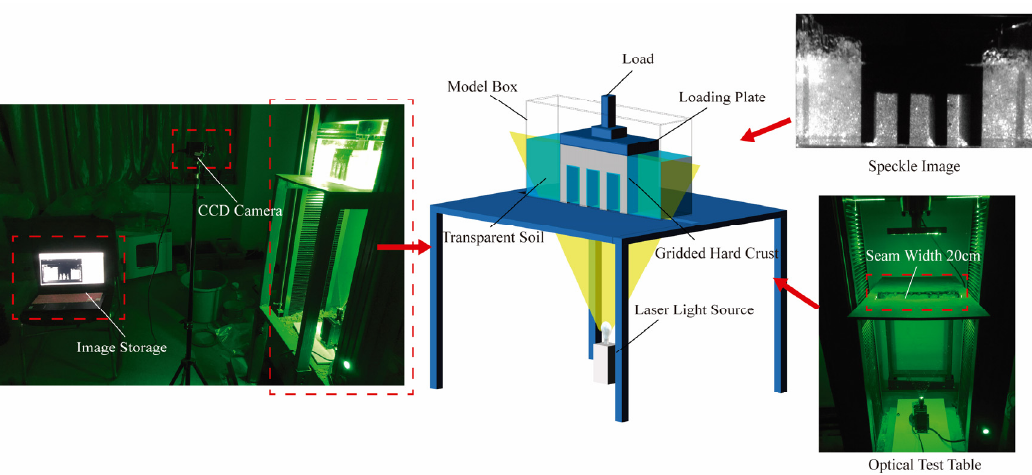
Figure 5. Experimental set-up.